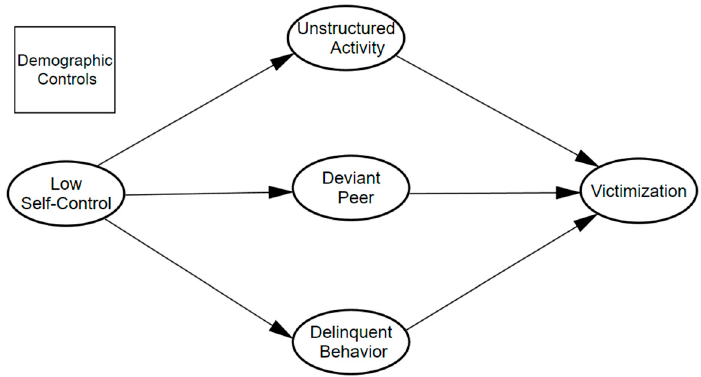
Figure 1. Conceptual model for the effects of low self-control and lifestyle/routine activities on vic- timization.